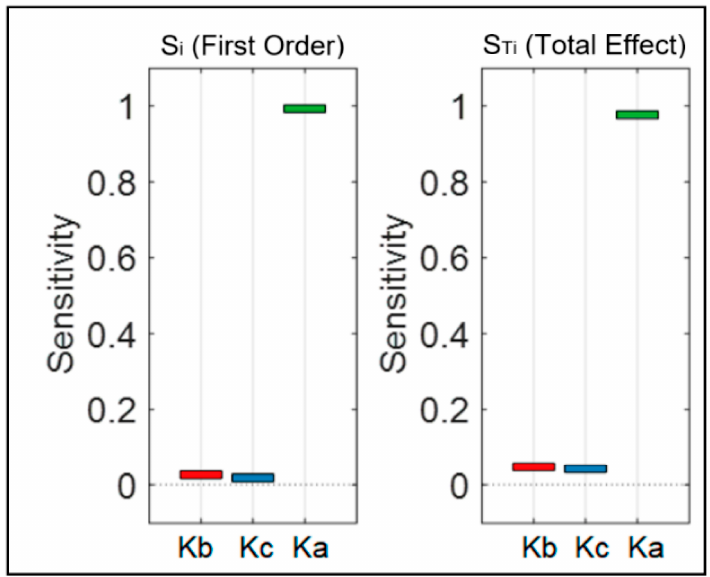
Figure 6. Sensitivity ranking for the SBP model. S i and S Ti show the results for first-order sensitivity and total effect sensitivity, respectively. Red, blue and green bars correspond to K b , K c and K a parameters respectively.